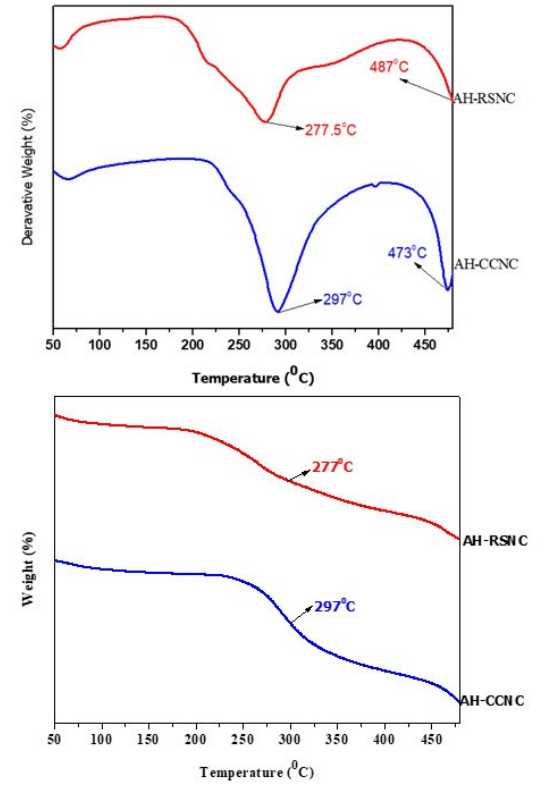
Figure 5. ( top ) DTG thermogram of AH-CCNC (blue) and AH-RSNC (red). ( bottom ) DTA thermo- Figure 5. (top) DTG thermogram of AH-CCNC (blue) and AH-RSNC (red). (bottom) DTA ther- gram showing degradation curves for AH-CCNC (blue) and AH-RSNC mogram showing degradation curves for AH-CCNC (blue) and AH-RSNC (red).